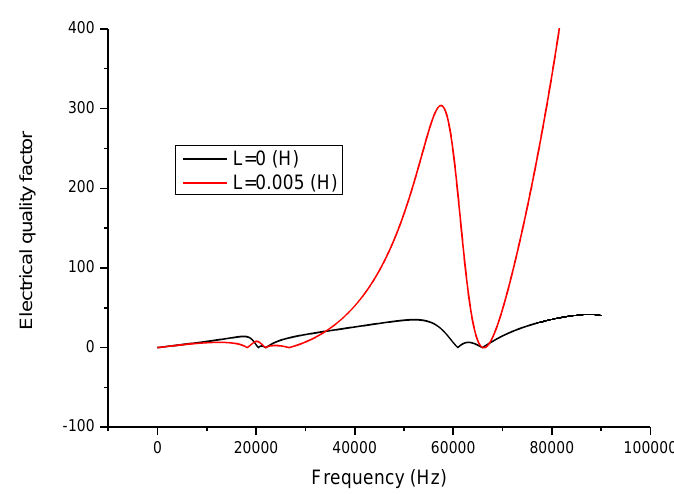
Figure 6. Frequency response of the electric quality factor.